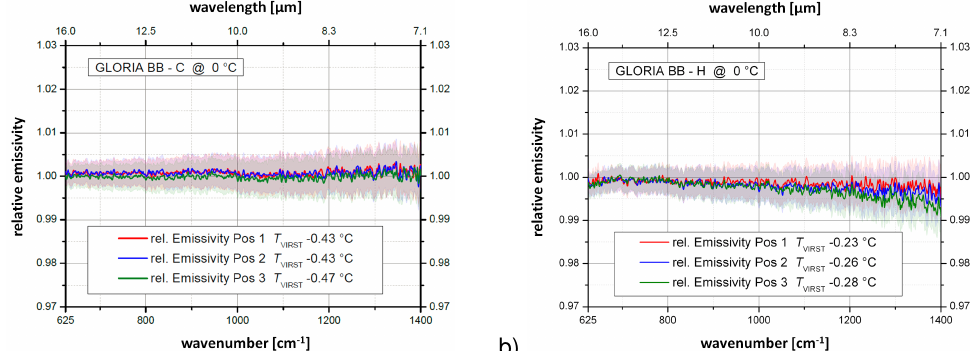
Fig. 5. Relative spectral emissivity of GBB-C (a) and GBB-H (b) . The shaded areas represent the uncertainty of each measurement (two sigma).